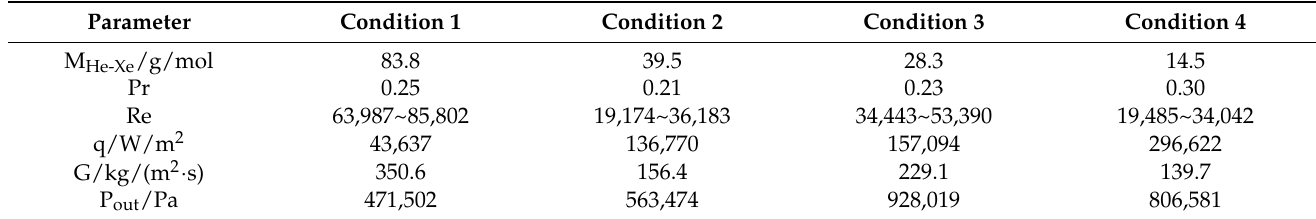
Table 7. Working conditions of the numerical simulation by Zhou et al. [14].